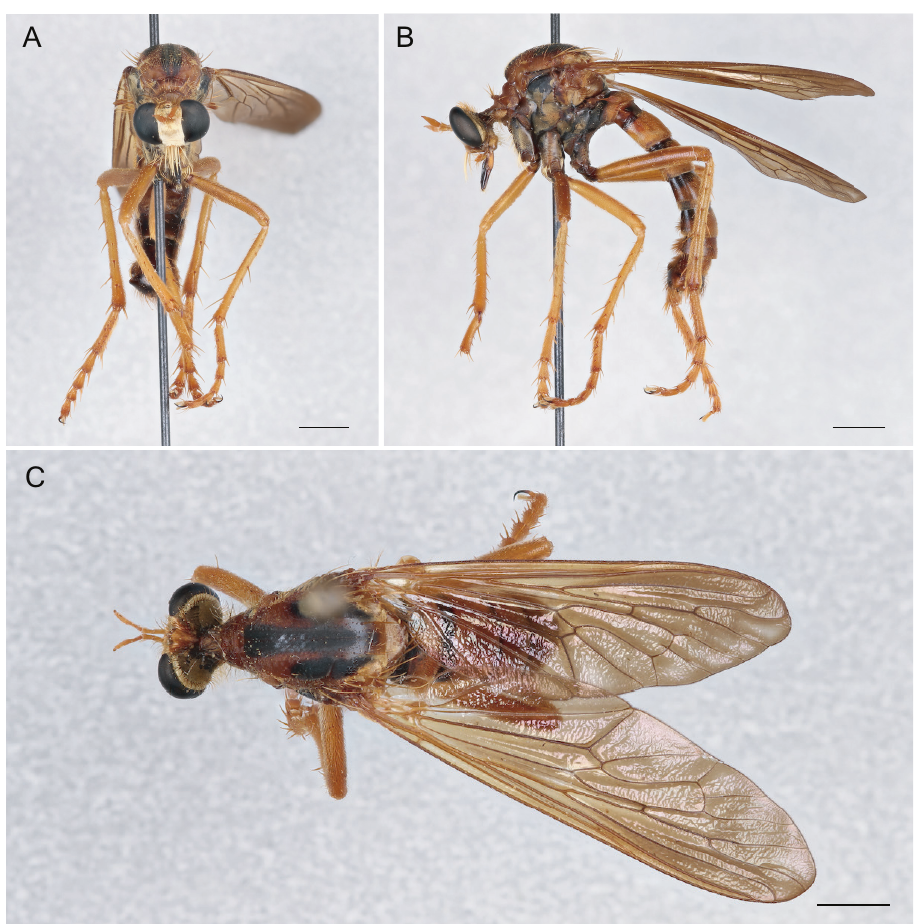
Figure 13. Saropogon fletcheri Bromley, 1934 Male (UCBMEP0280504): A anterior view B lateral view C dorsal view. Scale bars: 2